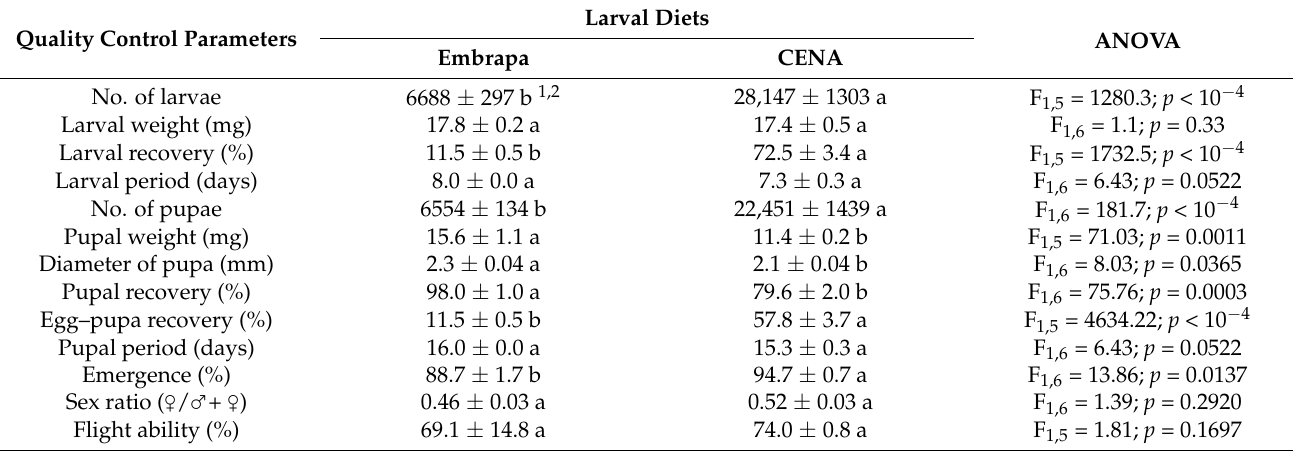
Table 4. Quality control parameters (mean ± SE) for Anastrepha fraterculus reared on a larval diet based on corn flour (Embrapa’s diet) or corn flour and carrageenan (CENA’s diet). Larval Diets Quality Control Parameters